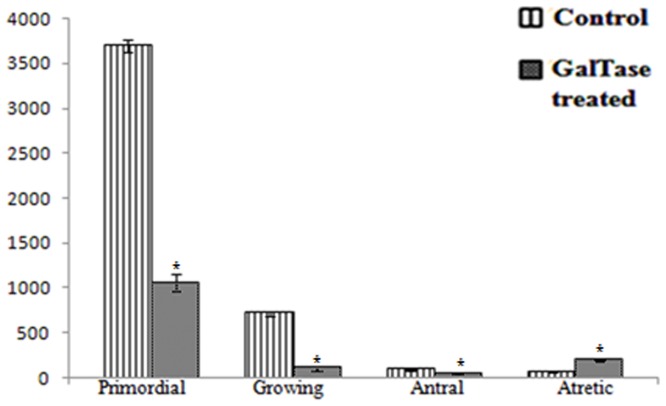
Quantification of different types of follicles per ovary.The figure represents overall reduction in the number of follicles of all stages and increase in atretic follicles in the GalTase-Ab exposed group as compared to the control. Values are expressed as mean±SEM. The numbers of follicles of all stages are significantly lower (P<0.0001) in the GalTase-Ab exposed group as compared to respective follicle type of the control group.